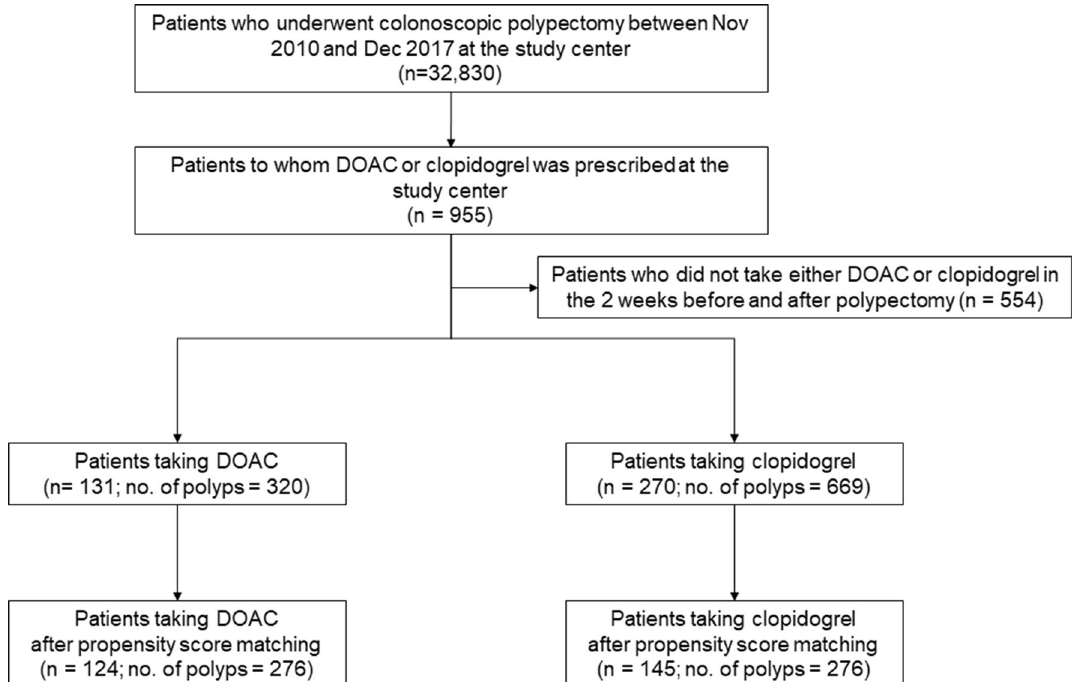
Figure 1. Flow chart for selecting patients taking either a direct oral anticoagulant or clopidogrel who underwent a colonoscopic polypectomy. DOAC Direct oral